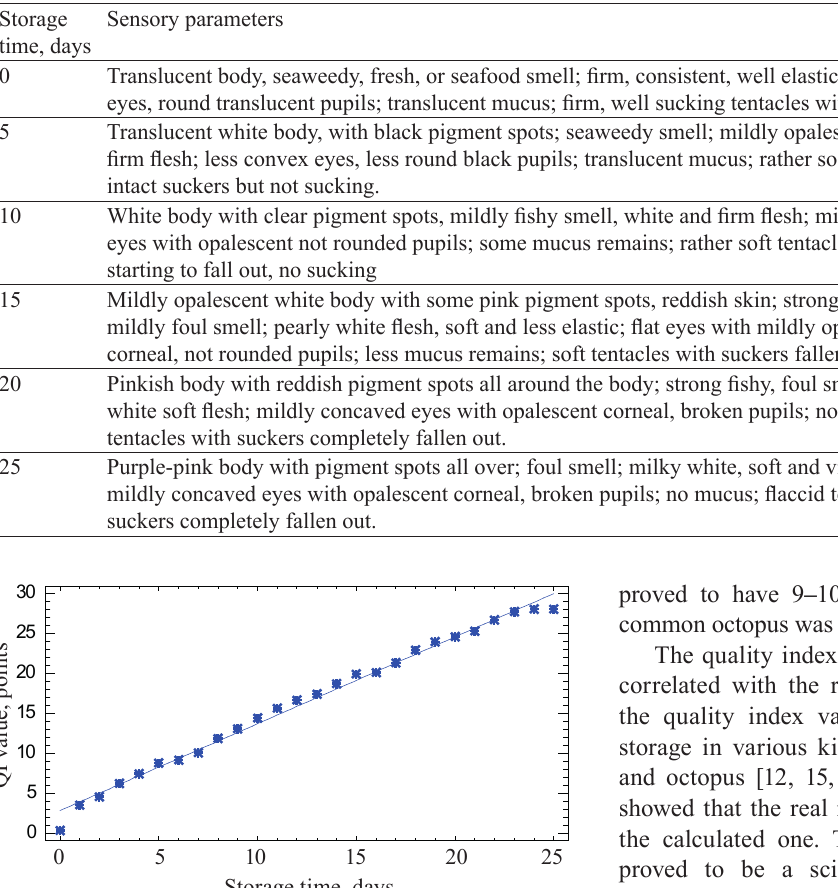
Figure 4 Quality index changes in the Loliginid squids during ice storage Table 3 Determining storage time and estimating the remaining shelf life of squids during ice storage using QIM scheme Sample